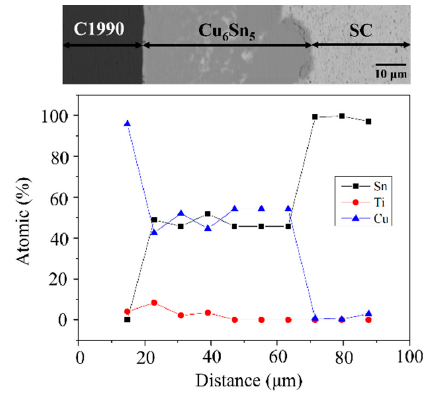
Figure 8. EPMA line scan and corresponding BEI micrograph of the SC/C1990 HP reaction couple at a reaction temperature of 255 ◦ C and reaction time of 2